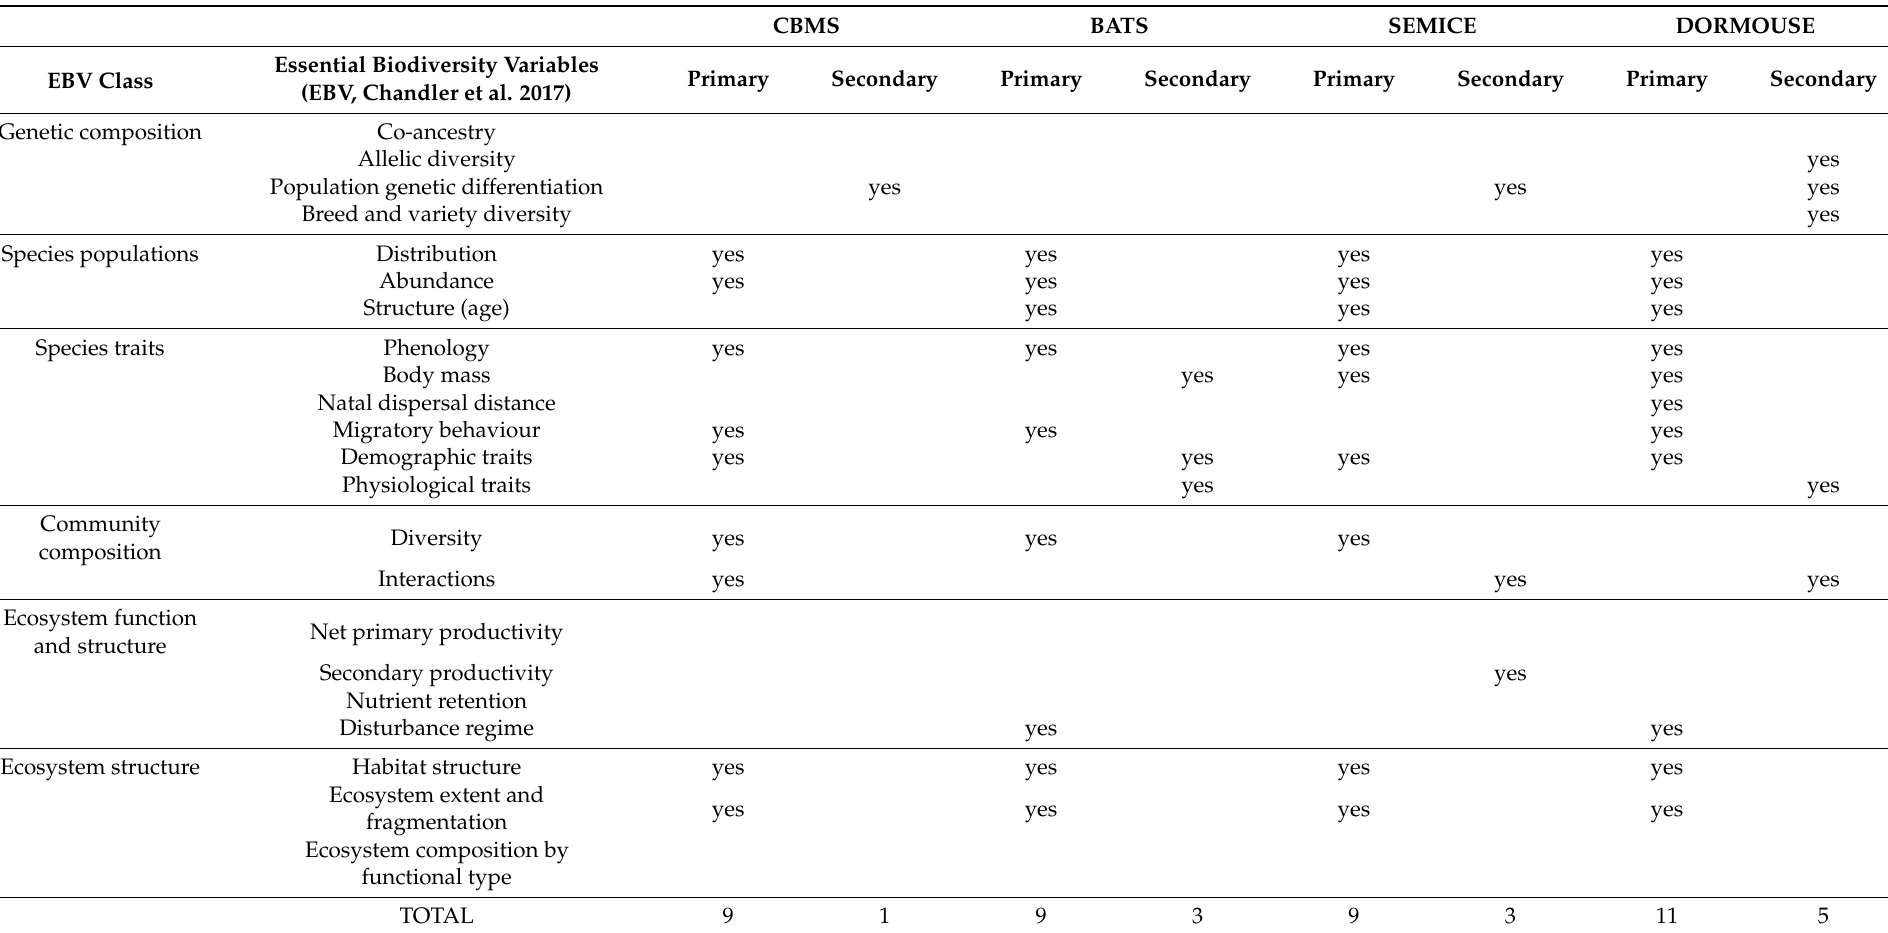
Table 1. Essential Biodiversity Variables (EBVs) covered by every monitoring programme as primary and secondary targets, defined as in